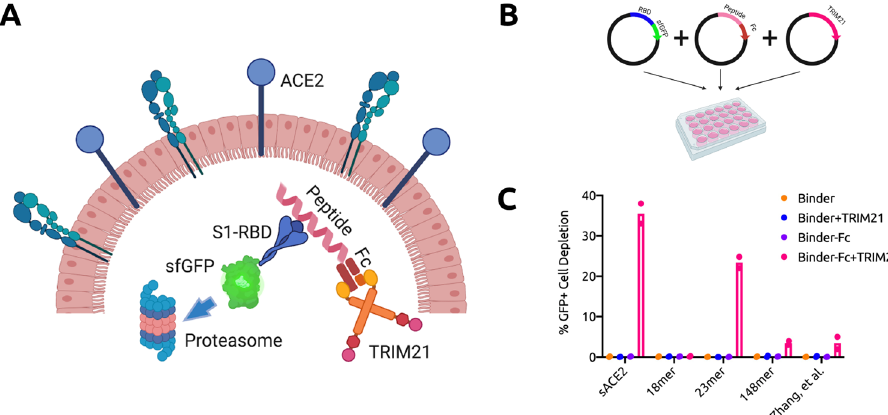
Fig. 2 TRIM21-mediated degradation of RBD via peptide targeting. a Architecture and mechanism of TRIM21-based degradation system. The Fc domain is fused to the C-terminus of RBD-targeting peptides. TRIM21 recognizes the Fc domain and tags RBD-sfGFP complexes for ubiquitin-mediated degradation in the proteasome. b Three plasmid assay used to experimentally validate degradation architecture in human HEK293T cells. All CDS are inserted into the pcDNA3.1 backbone. c Analysis of RBD-sfGFP degradation by fl ow cytometry, in the absence or presence of Fc (in cis), TRIM21 (in trans), or both. All samples were performed in independent transfection duplicates ( n = 2) and gated on GFP + fl uorescence. Mean percentage of GFP + cell depletion was calculated in comparison to the RBD-sfGFP only